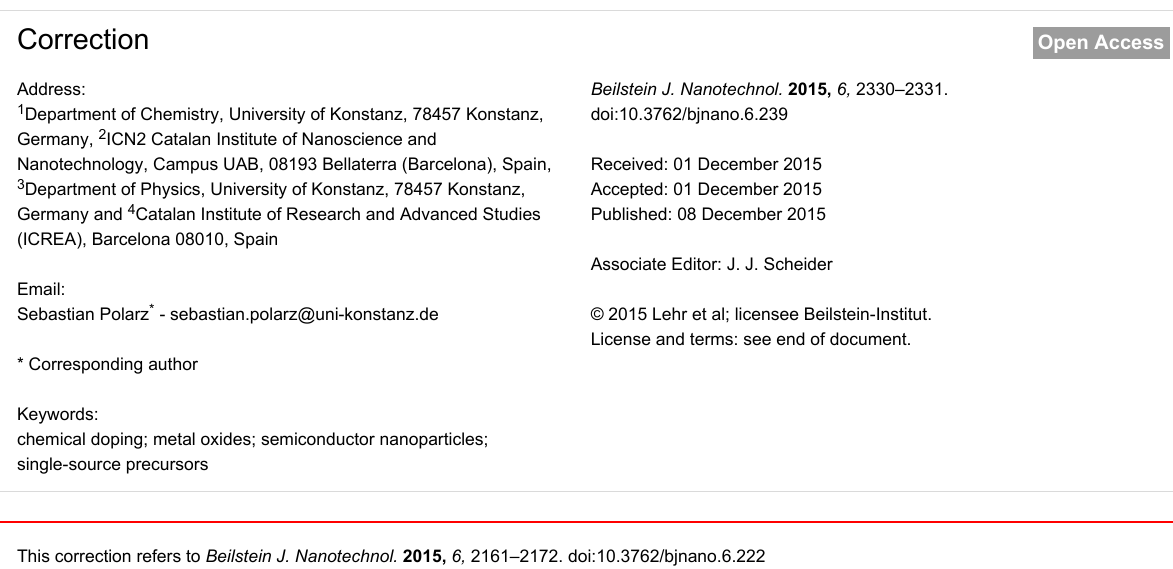
Figure 8. The correct form of Figure 8 is as